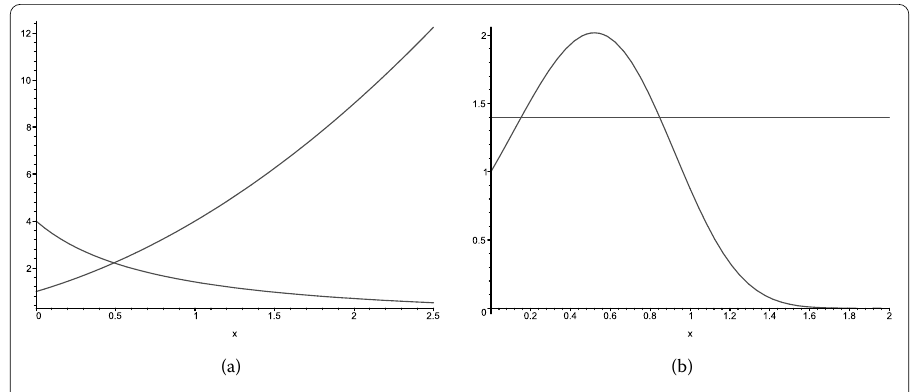
Figure 2 ( a ) The intersection point is the point where F (cid:5) ( x ) = 0. ( b ) Graph of z = F ( x ) function such a = 0.1, b = 0.8, k = 0.7 and m =